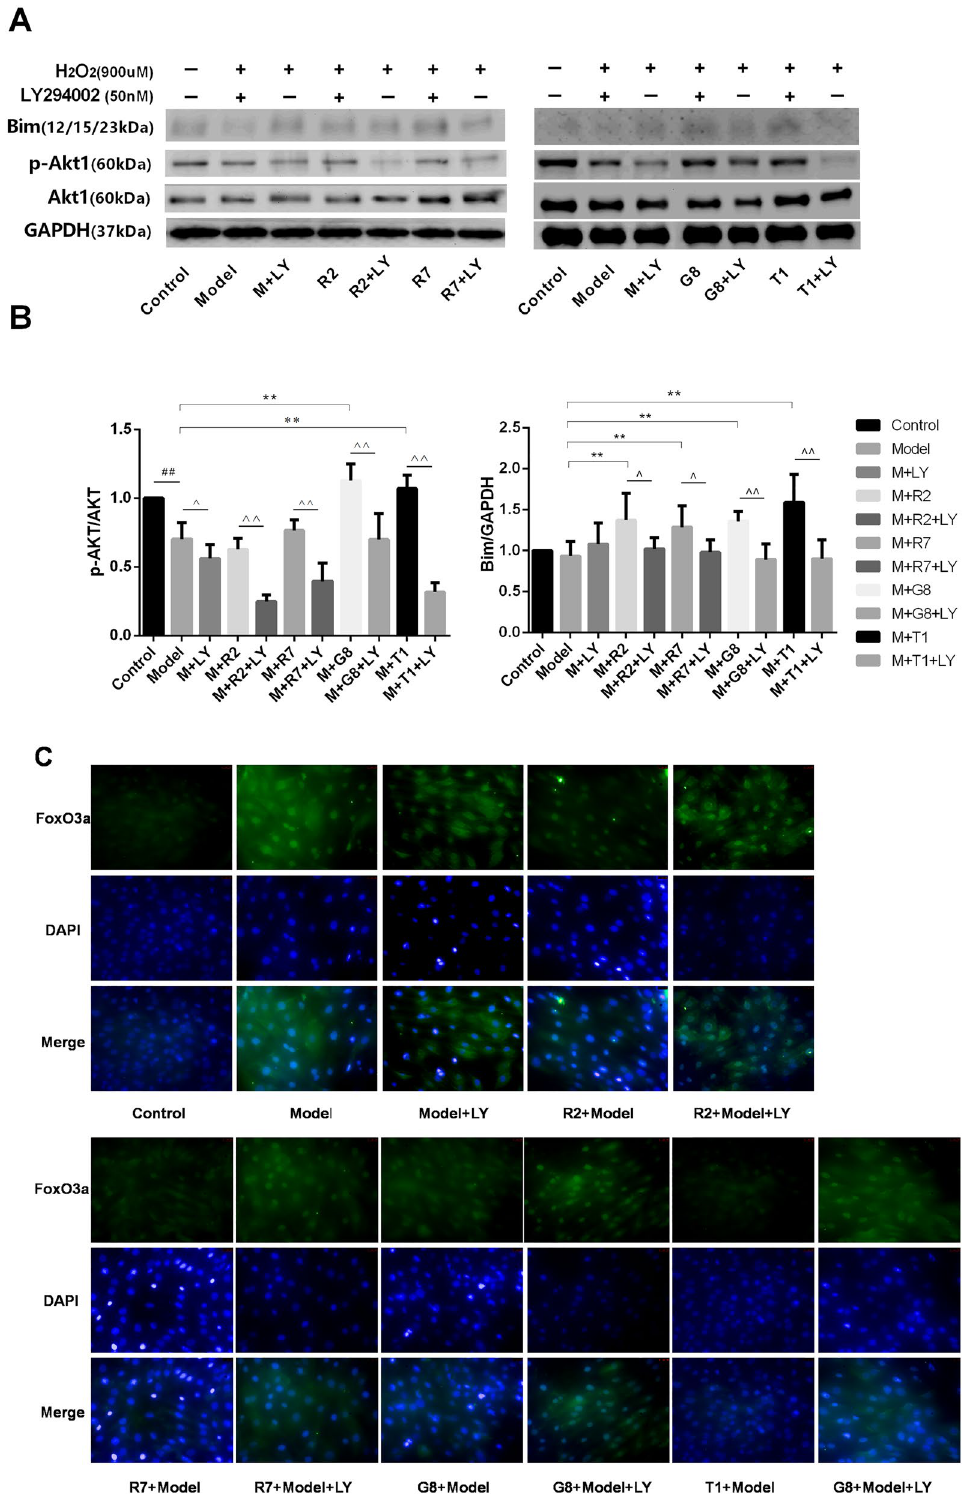
Figure 6. PI3K/Akt/FoxO3a pathway is involved in a protective action of representative monomers G3, G8, R2, R7 and T1 of SWTX on H9c2 cells exposed to H 2 O 2 (900 μM) for 22 h, and PI3K inhibitor LY294002(LY, 50 nM) was used to further confirm the effects of SWTX on PI3k/Akt/FoxO3a signaling pathway. ( A ) Representative Western blots shown the effects of G3, G8, R2, R7 and T1 on the expression of Akt, p-Akt, Bim, and the interfering effects of LY294002 (LY), while GAPDH was used as loading control. ( B ) The expression of p-Akt, Akt in H9c2 cells was essayed by western blotting using a Image J analyzer. ( C ) Representative Immunofluorescence staining shown the effects of G3, G8, R2, R7 and T1 on the translocating level of FoxO3a to nucleus on H9c2 cells was essayed by Immunofluorescence staining. Data are expressed as the mean value ± SD from three independent experiments. ## P < 0.01 versus control group, * P < 0.05, ** P < 0.01, versus model, ^ P < 0.05, ^^ P < 0.01, the monomer versus corresponding monomer + LY294002